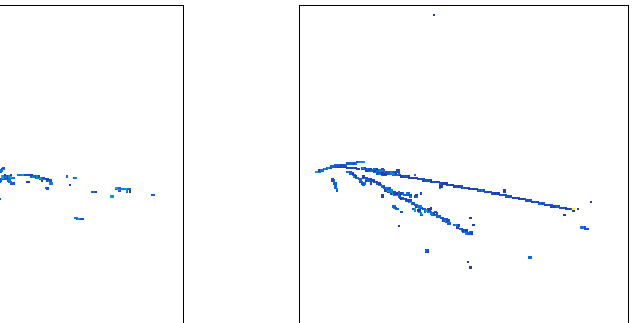
each pixel corresponds to an area of 1 × 1cm 2 , and the colour represents the deposited energy (blue is lowest, yellow is